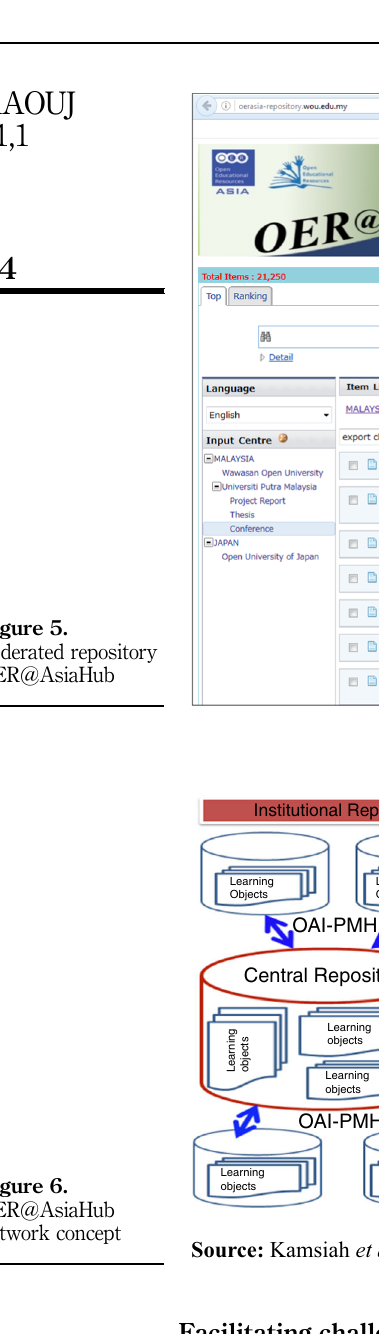
Figure 6. OER@AsiaHub network concept